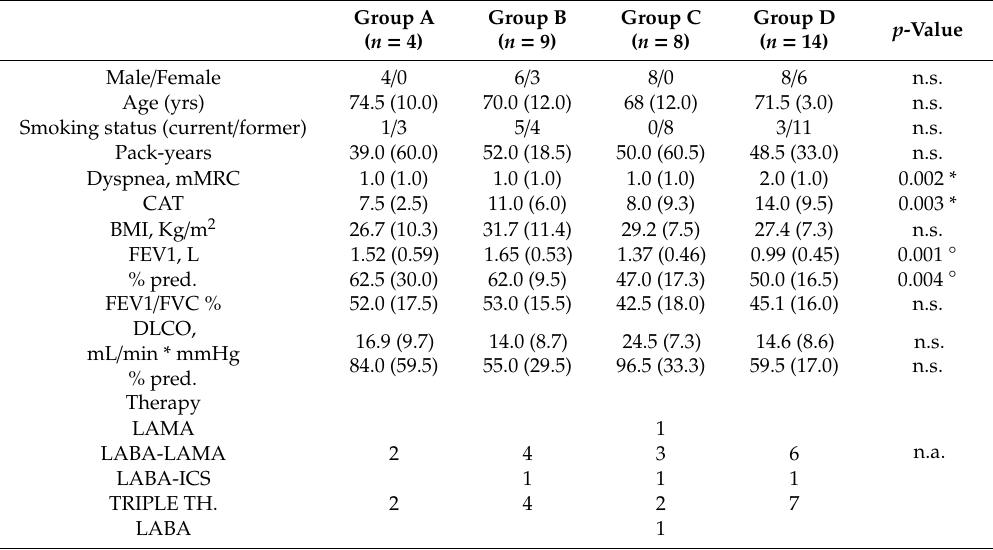
Table 1. Main anthropometric and clinical characteristics of the four 2011 Global Initiative for Chronic Obstructive Lung Disease (GOLD)